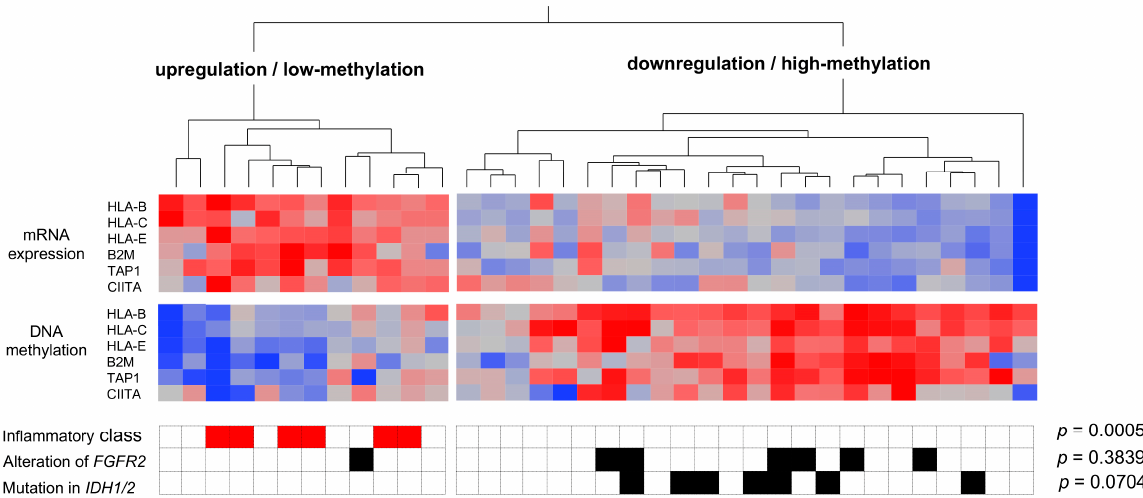
Figure 3. Hierarchical clustering analysis using z-scores of mRNA expression and methylation levels of antigen-presenting machineries. The color map ( red-gray-blue ): red , degree of increased mRNA expression or methylation density; blue , degree of decreased mRNA expression or methylation density. CCAs in the cluster with high expression (red rectangle) and low methylation levels (blue rectangle) were considered upregulation/low-methylation pattern, and those with low expression (blue rectangle) and high methylation levels (red rectangle) were determined as downregulation/high- methylation pattern, respectively. Tumors classified as inflamed group, which are indicated in Figure 1, are shown with red squares. Similarly, tumors harboring FGFR2 alterations and mutations in IDH1/2 are shown as black squares. All six tumors considered to have an inflamed tumor phenotype showed upregulation and low-methylation pattern in the genes involved in antigen presentation, whereas 24 of 30 tumors with a non-inflamed tumor phenotype showed downregulation with high- methylation pattern ( p = 0.0005). All seven tumors carrying mutations in the IDH genes and six of the seven tumors carrying FGFR2 alterations were classi fi ed into the downregulation/high-methyl- ation pa tt ern group ( p = 0.0704 and 0.3839 for mutations in the IDH genes and alterations in the FGFR2 genes, respectively).